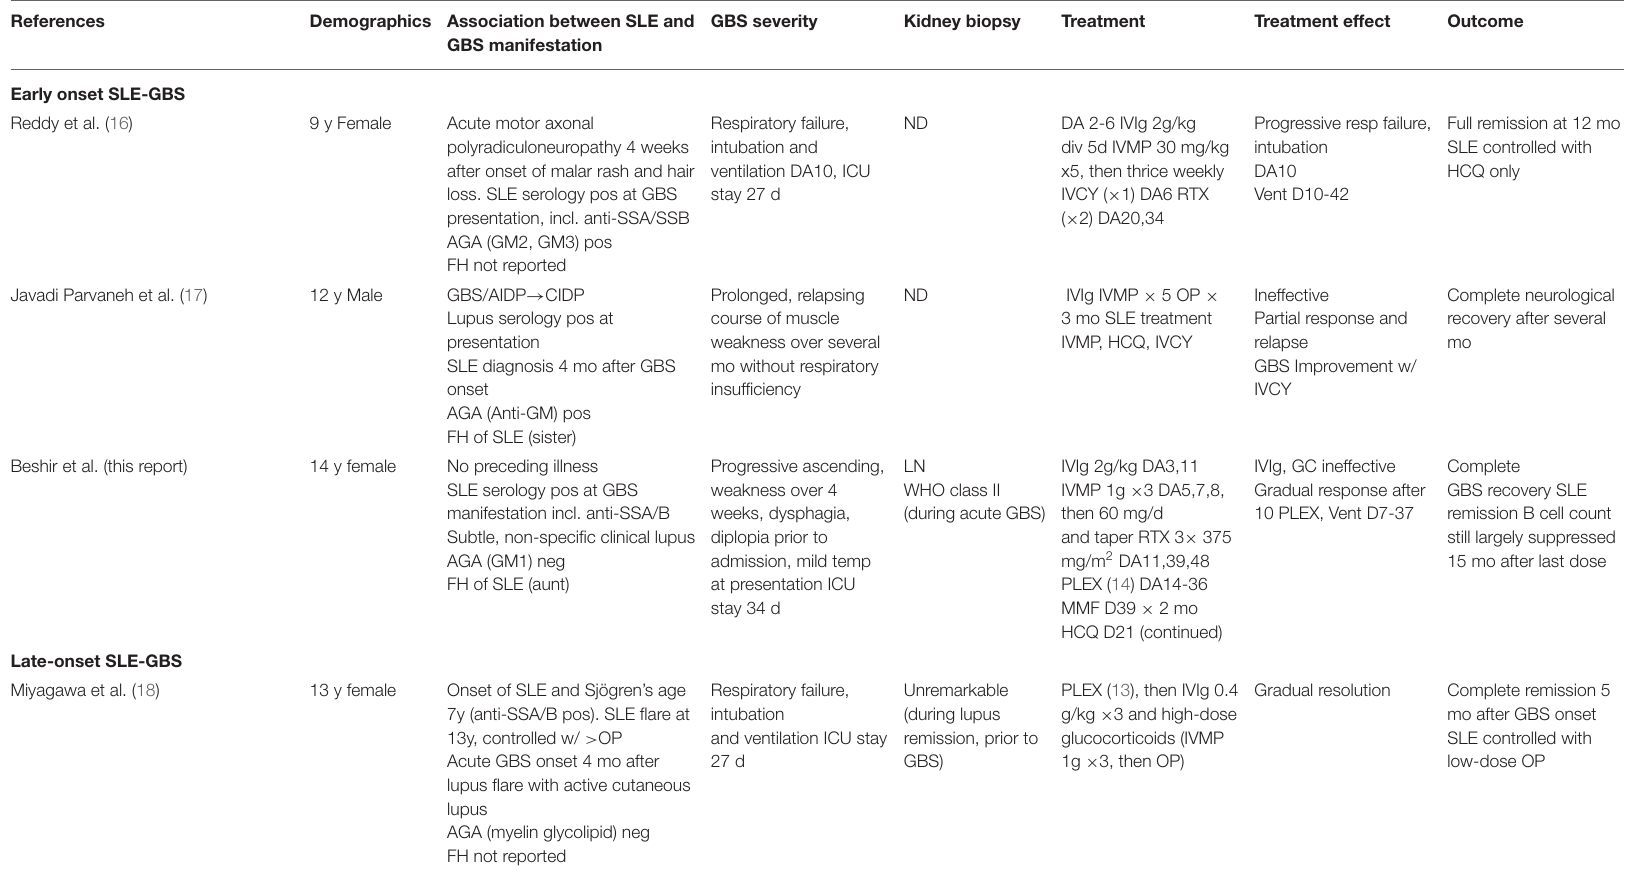
TABLE 2 | Literature review of pediatric SLE-GBS cases (attached